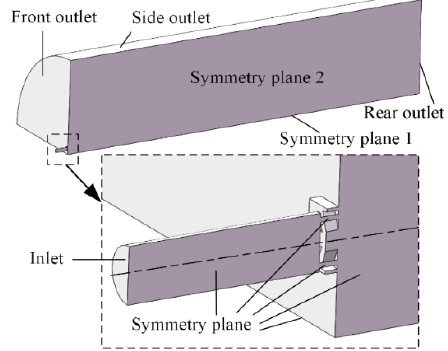
Figure 5. Model boundary conditions.